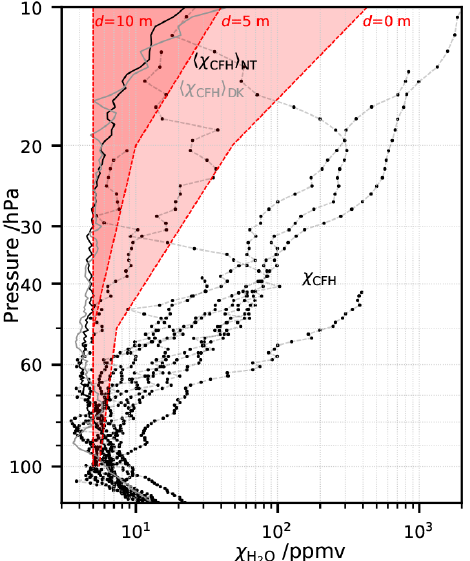
Figure 15. Comparison of expected contamination from the balloon envelope with contaminated χ H observations by the 2 O CFH in StratoClim 16/17. Black dots: all contaminated profiles of StratoClim 16/17 (see Fig. 1), black line: Nainital 2016 season average, grey line: Dhulikhel 2017 season average, light red region: expected contamination when the payload travels directly below the balloon or within a 5m radius 55m below the balloon, dark red region: expected balloon contamination if the payload stays outside the 5m radius circular region 55m directly below the